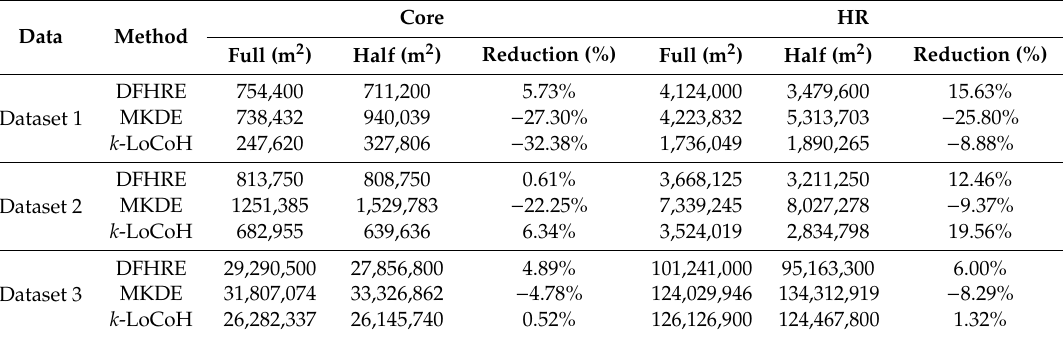
Figure 21. HRs of the DFHRE, MKDE and k -LoCoH methods for Dataset 3. Table 4. Area changes in the results of the DFHRE, MKDE, and k -LoCoH for the three datasets.